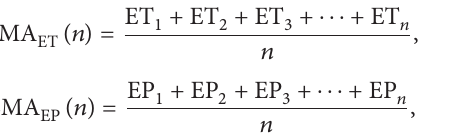
Amazon allows users to bid on unused EC2 capacity among 42 types of spot instances [18]. Their prices, which are referred to as spot prices, are changing dynamically based on supply and demand. Figure 4 shows a spot price fluctuations example during seven days in December 2010 for c1-xlarge (High-CPU Spot Instances—Extra Large) [19]. Our proposed system model is based on the characteristics of Amazon EC2’s spot